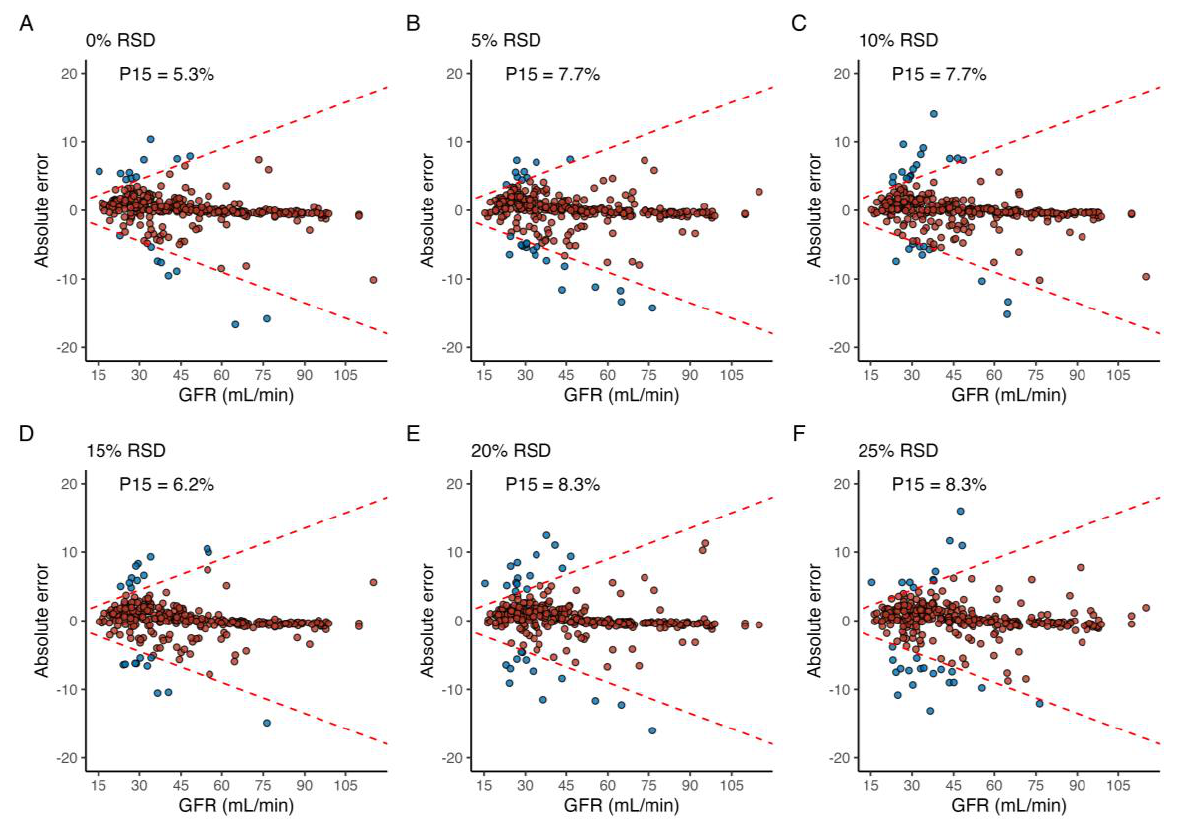
Figure 4. The effect of shifts in time over multiple sample points, where the ( A ) reference run is compared to when shifts in sample time are normally distributed around the optimal sample time with a relative standard deviation (RSD) of ( B ) 5%, ( C ) 10%, ( D ) 15%, ( E ) 20%, and ( F ) 25%. Blue and red fill indicates an individual error greater than or less than 15%, respectively. The label in the upper-left corner denotes the proportion of individuals with a relative prediction error greater than 15% (P15) for each level of RSD.